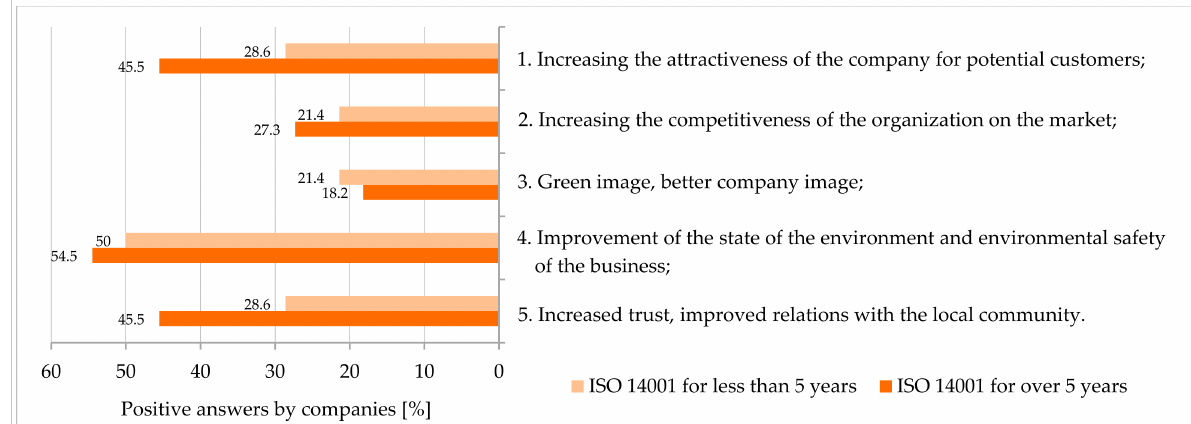
Figure 9. Analysis of the external benefits resulting from the implementation ISO 14001 depending on the duration of the system operation in